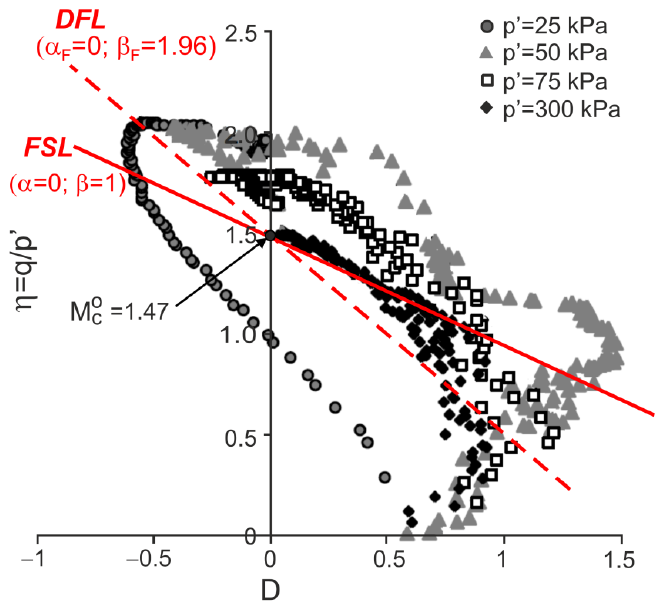
Figure 10. Stress ratio–dilatancy relationships for the drained triaxial compression of granitic residual soil with 1% of cement 52.5R (adapted from [7]). Reprinted from Publication Proceedings of